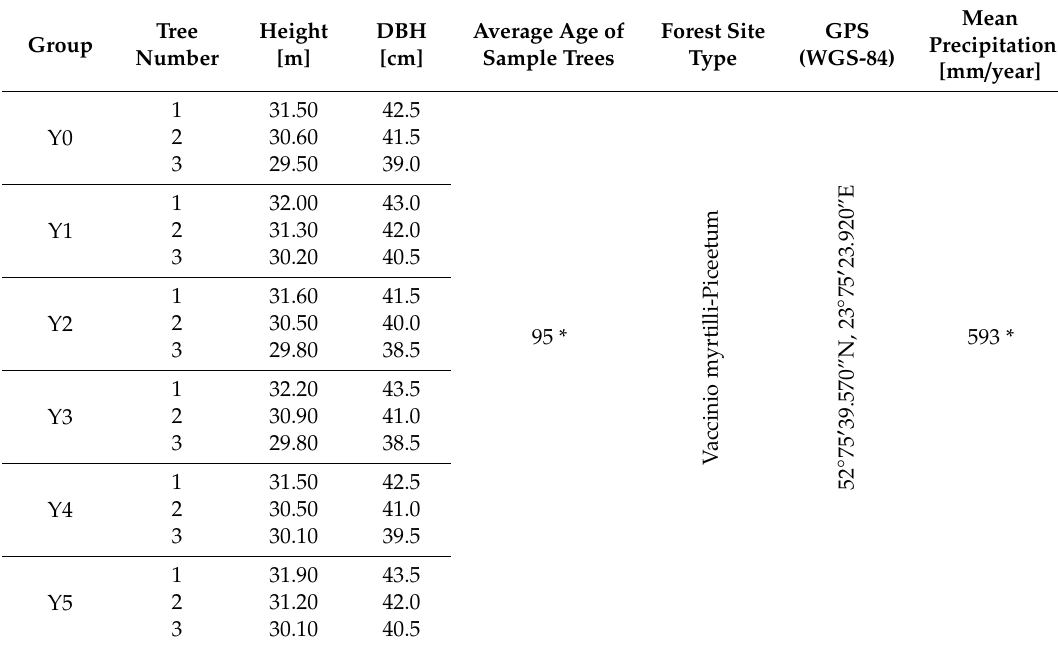
Table 1. Basic locality and stand characteristics.